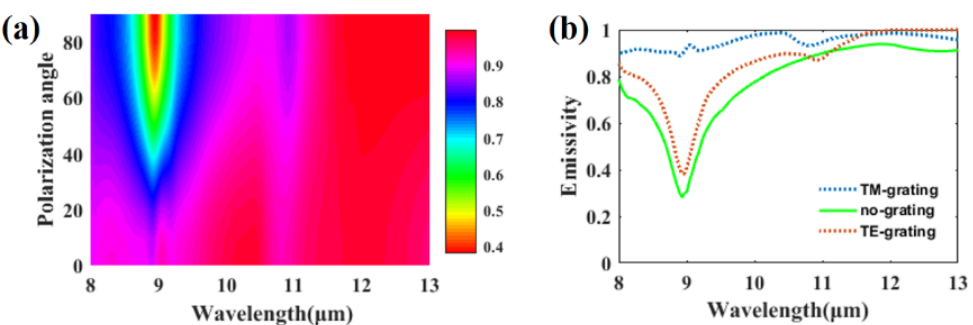
Figure 9. ( a ) Emissivity of the proposed structure at atmospheric transparent window varying with polarization angle. ( b ) Emissivity of the proposed structure at TM and TE incidence.